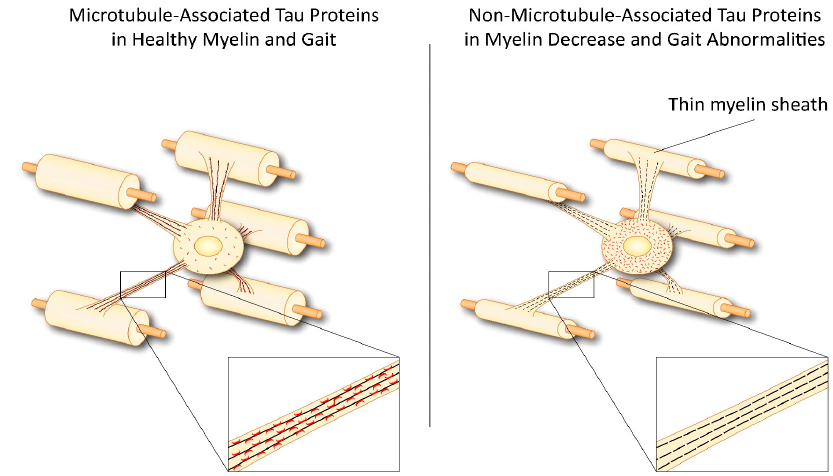
Figure 1. The Sorting of Tau into Oligodendrocyte (OLG) Processes for Neuronal Health. The